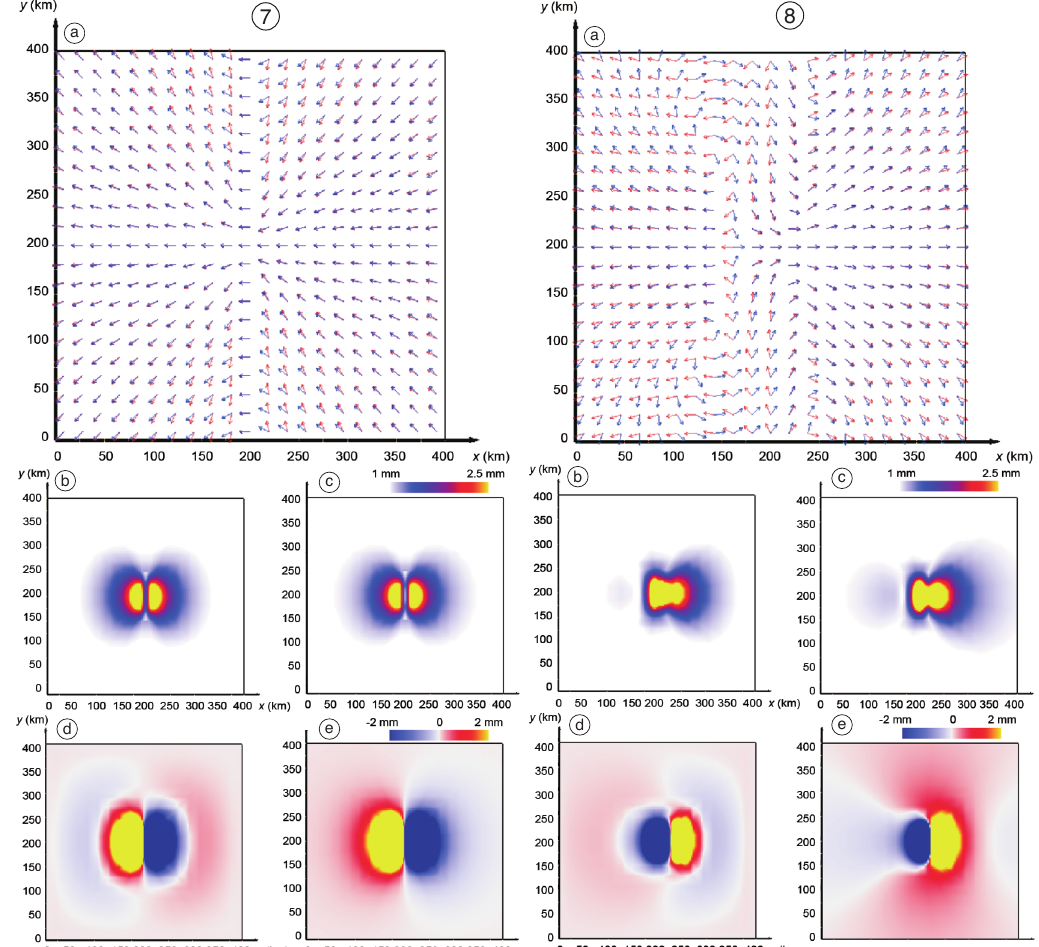
Fig. 7a-e. Same as fig. 3a-e but for a normal dip slip with δ = 90° and φ = 0° when the the bottom and lateral nodes are fixed. Fig. 8a-e. Same as fig. 3a-e but for a normal dip slip with δ = 20° and φ = 0° when the the bottom and lateral nodes are